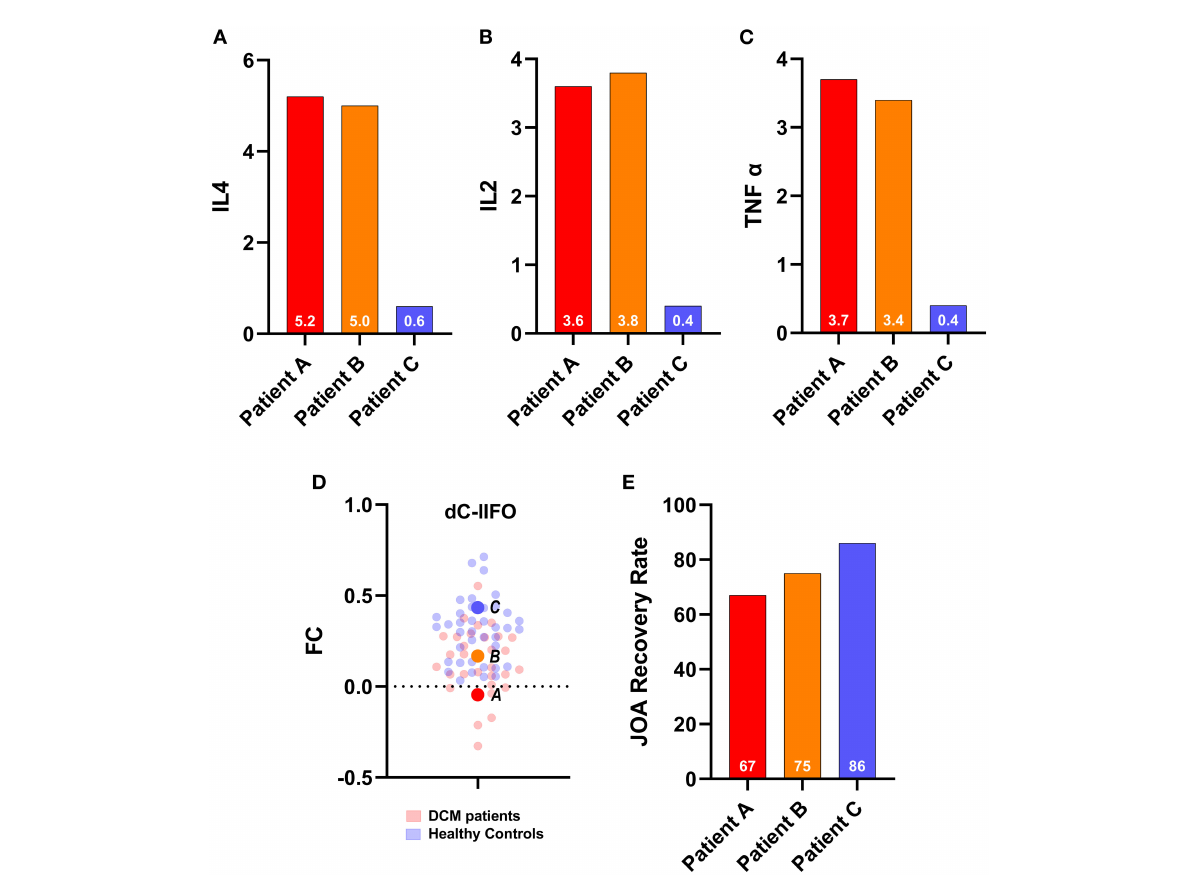
FIGURE4 Cases report. Upper panel: The inflammatory cytokines of the three of 33 depressed degenerative cervical myelopathy patients. (A) IL4 for three patients, (B) IL2 for three patients, (C) TNF alpha for three patients, (D) The FC for three patients and their relative position among DCM patients and healthy controls, and (E) JOA recovery rate for three patients. JOA, Japanese Orthopedic Association; dC, dorsal caudate; IFO, inferior frontal operculum; FC, functional connectivity; DCM, degenerative cervical